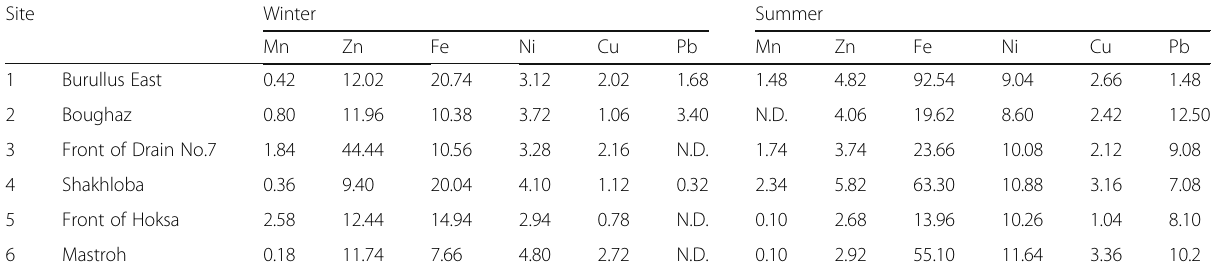
Table 2 Average values of heavy metals ( μ g/L) in surface water of Burullus Lake during winter and summer 2014 Site Winter